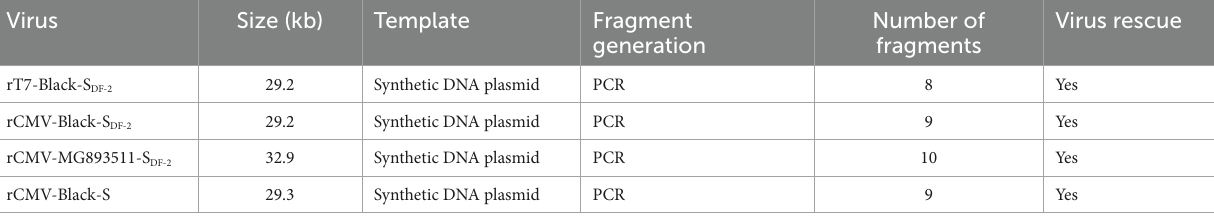
TABLE 1 Cloning RNA virus genome using synthetic genomics platform.